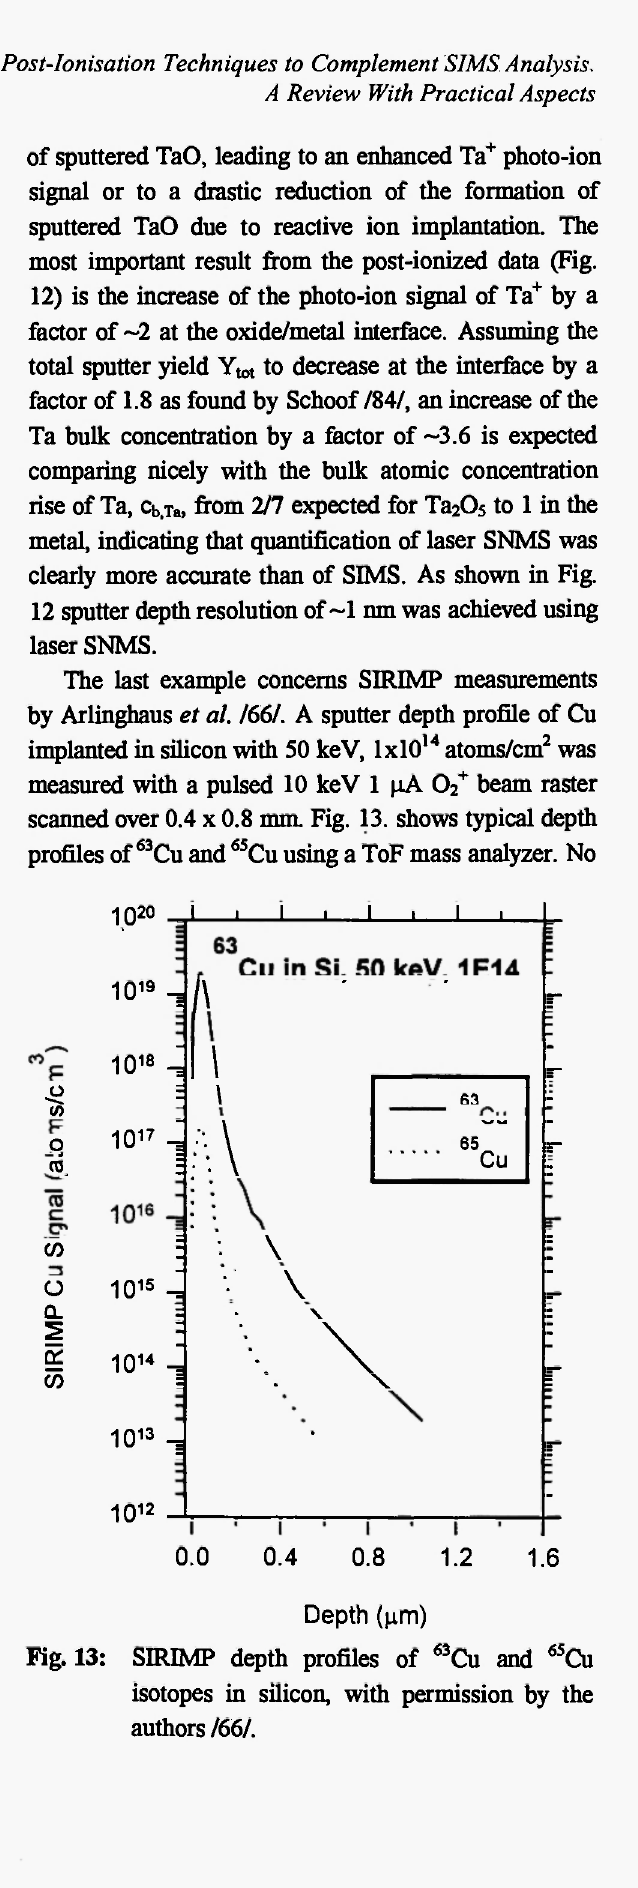
Fig. 13: SIRIMP depth profiles of 63 Cu and 65 Cu isotopes in silicon, with permission by the authors